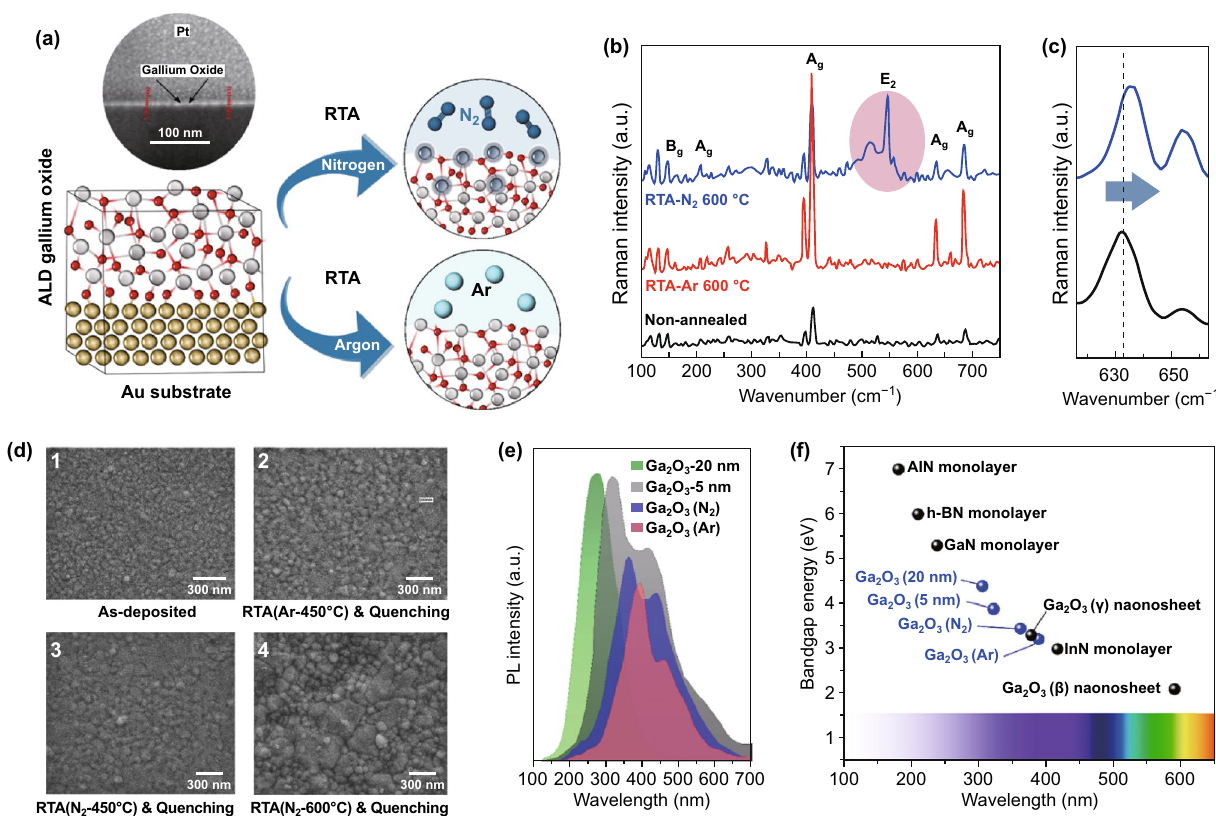
Fig. 2 Schematic of RTA treatment accompanied by characterization results of ultra-thin heterostructured films. a Graphical scheme for RTA of 5-nm-thick gallium oxide film in Ar and N 2 atmosphere. b Typical Raman characteristics of RTA-treated gallium oxide films in Ar and N 2 atmosphere, c Raman shifts and d FESEM microstructural observations. e Photoluminescence spectra of as-deposited and RTA-treated gallium oxide films. f Comparative diagram of E g of selected two-dimensional (2D) metal nitrides accompanied by the results of present